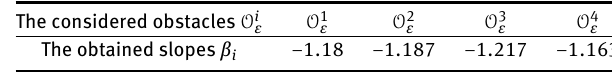
Table 2: The obtained slopes β i of the lines associated with the obstacles O i ε , i = 1, ... , 4 . The considered obstacles O i ε O 1 ε O 2 ε O 3 ε O 4 ε The obtained slopes β i −1.18 −1.187 −1.217 −1.163